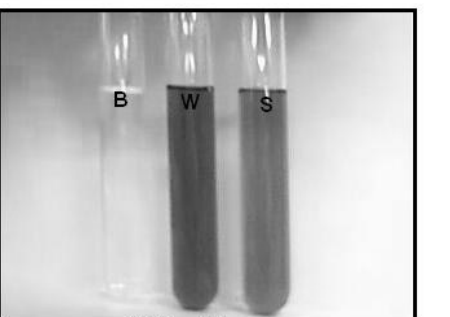
Figure 4. Effect of sodium nitrite.